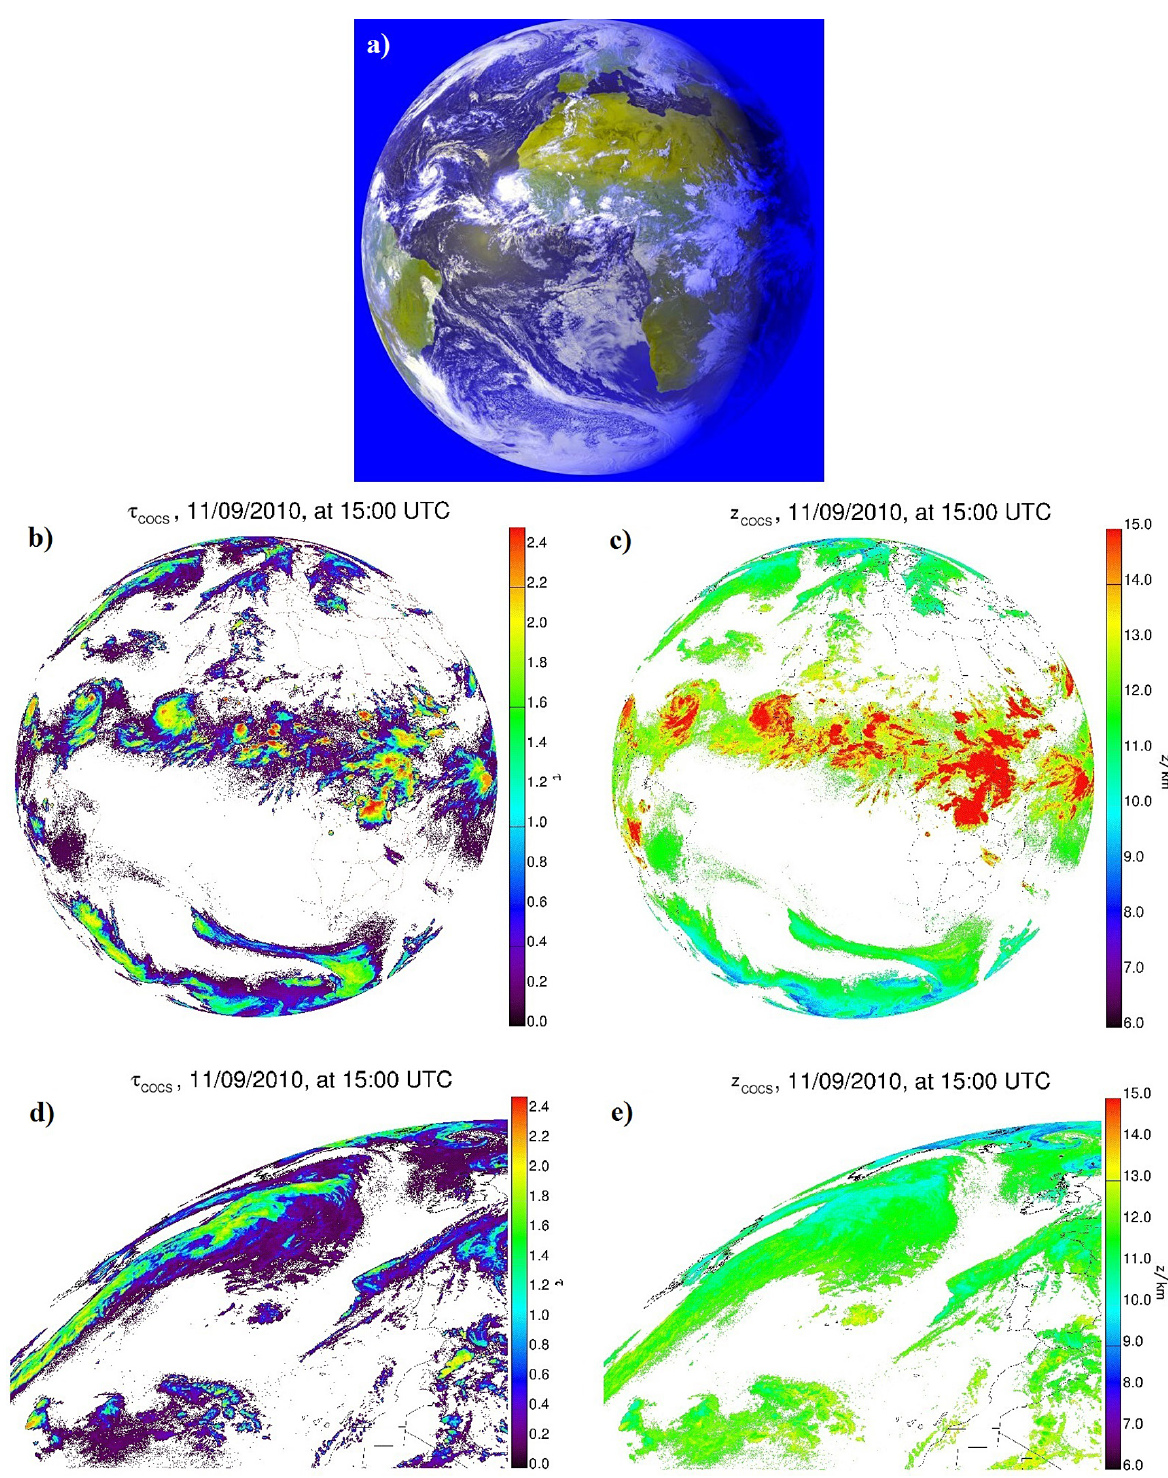
Figure 5. False colour composite of SEVIRI (VIS006, VIS008, IR108) at 15:00UTC on 11 September 2010 (a) . Ice optical thickness τ (b) and top altitude z (c) of cirrus clouds retrieved by COCS at 15:00UTC on 11 September 2010. For the same time slot an enlarged view on the North Atlantic region shown for ice optical thickness τ (d) and top altitude z (e) . Coastlines and geographic boundaries are coloured